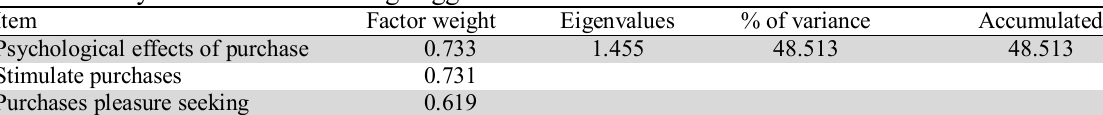
The summary of factors influencing